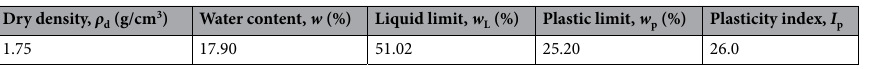
Dry density, ρ d (g/cm 3